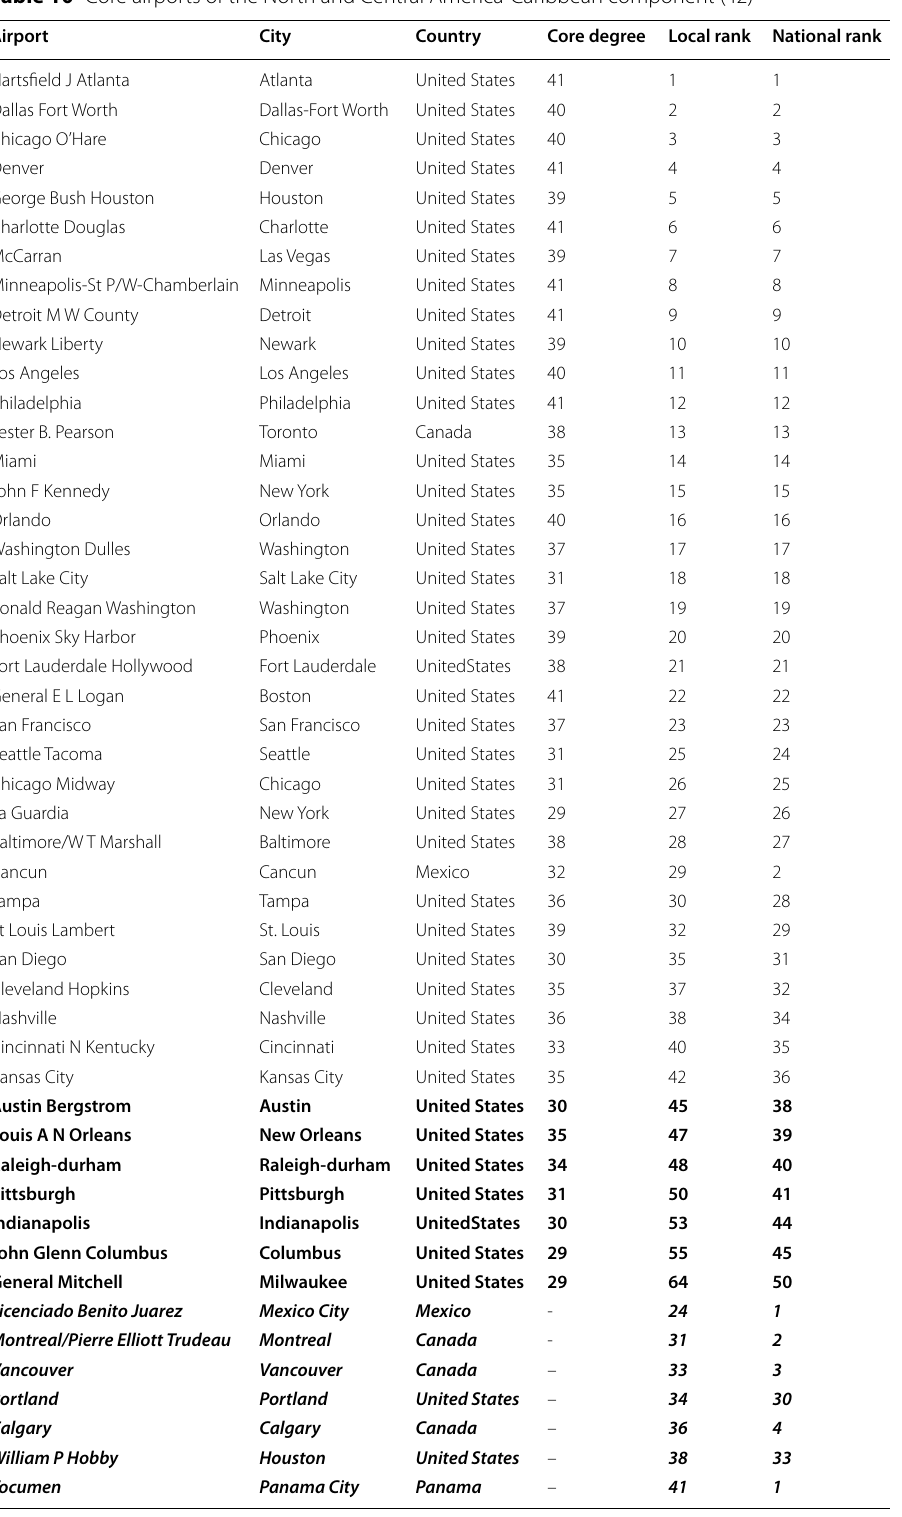
Table 10 Core airports of the North and Central America-Caribbean component (42) Airport